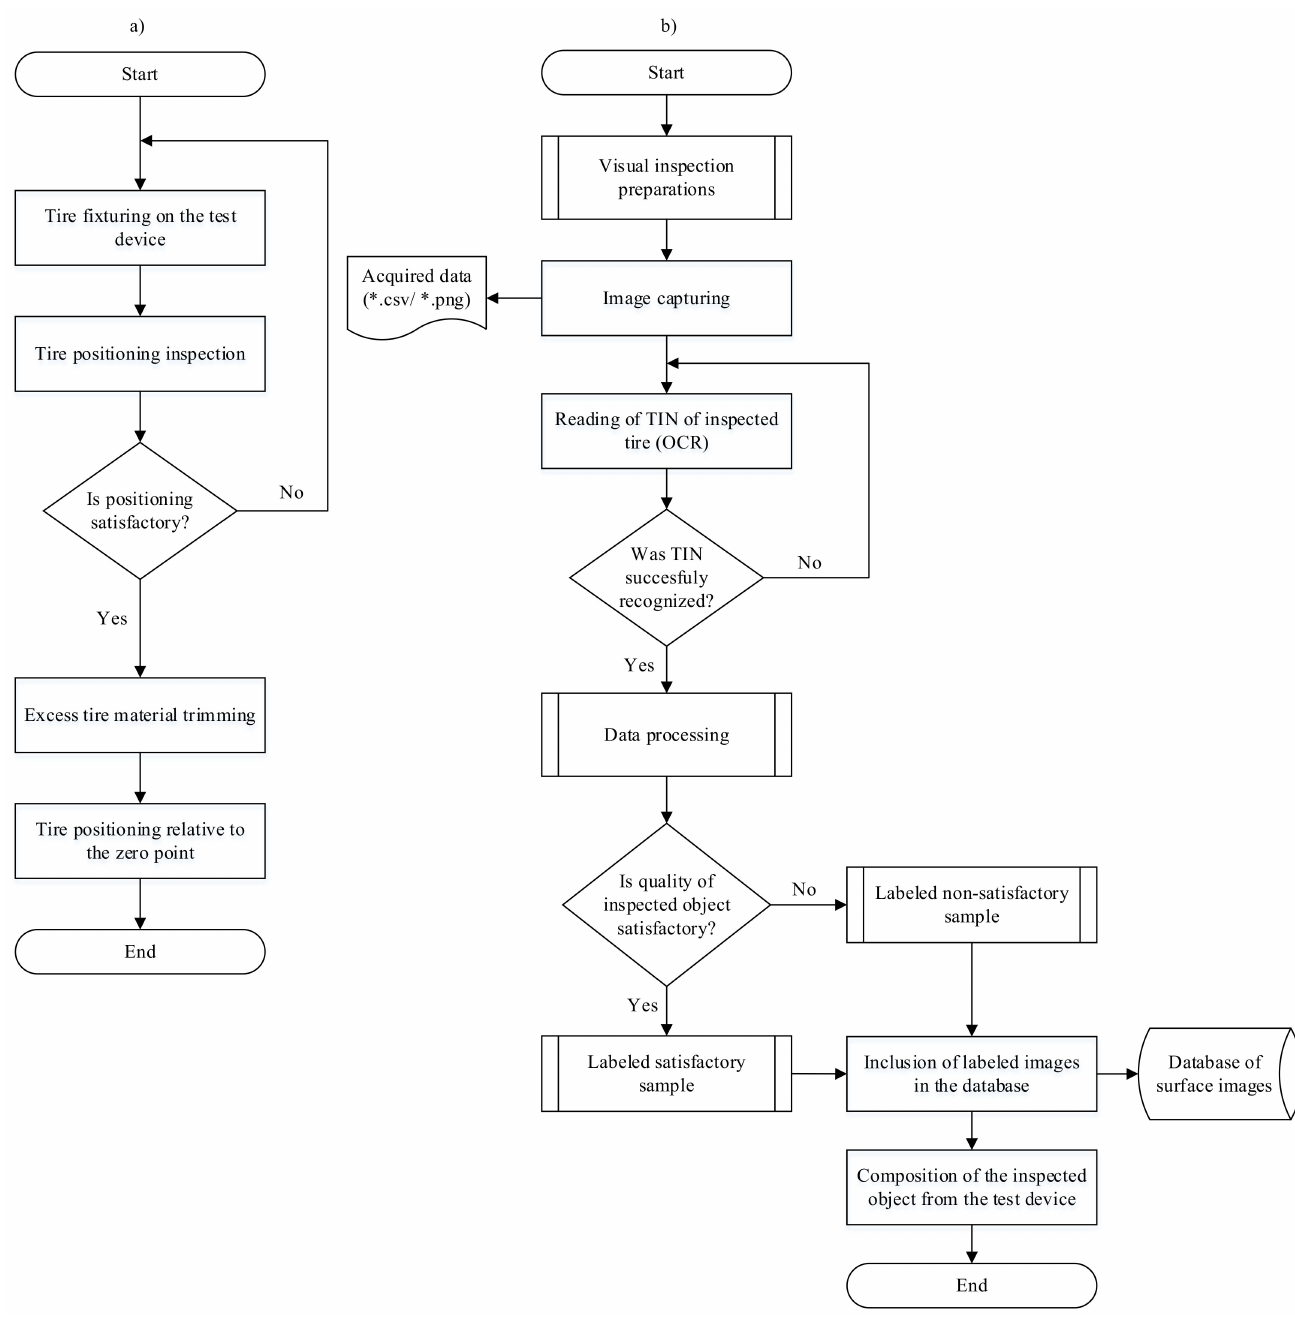
Figure 11. Flowcharts: visual inspection preparations ( a ) and methodology of tire visual inspec- tion ( b